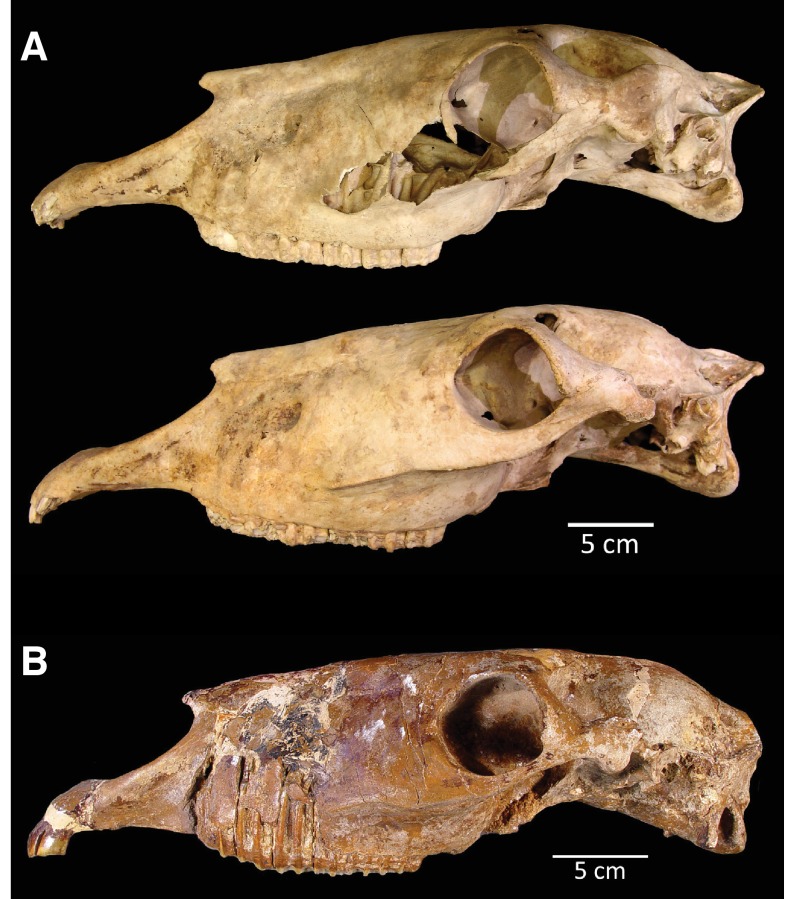
The two crania assigned to H. francisci.(A) LACM(CIT) 109/156450 from Nevada, identified through mitochondrial and nuclear palaeogenomic analysis. Upper: right side (reflected for comparison), lower: left side. (B) Part of the H. francisci holotype, TMM 34–2518 from Texas.